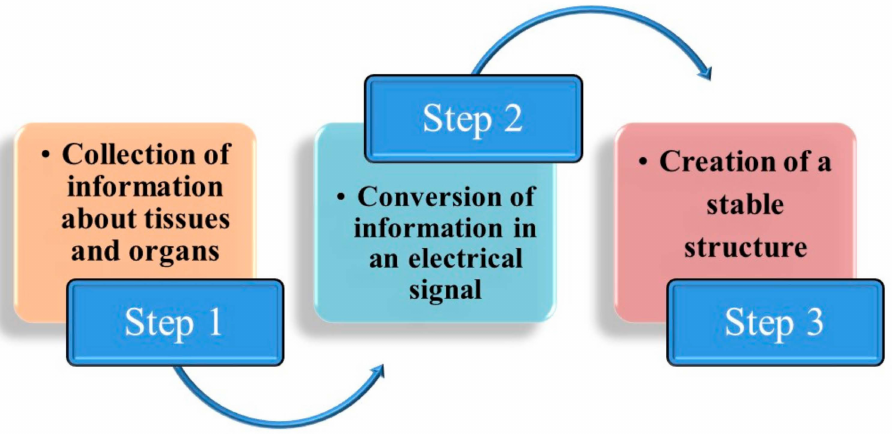
Figure 4. Illustrative diagram showing the steps for the 3D